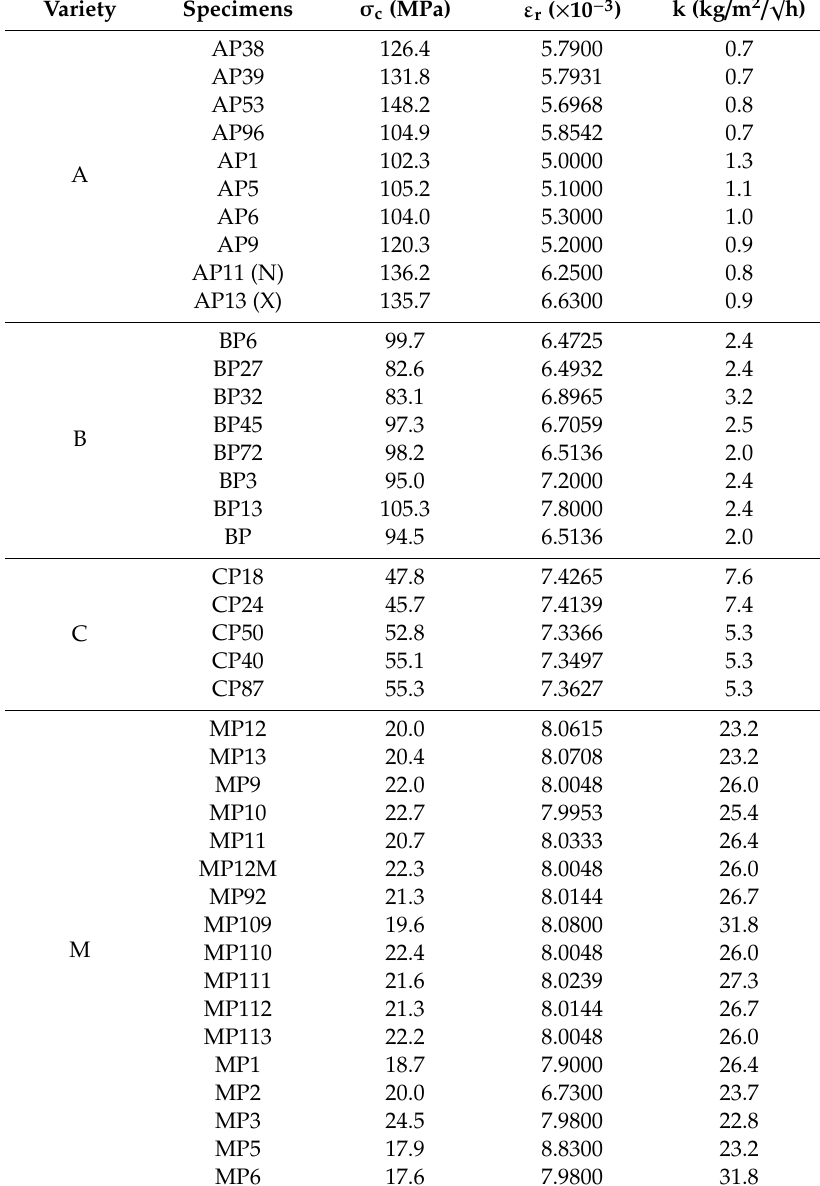
Table 3. Values of physical and mechanical properties of